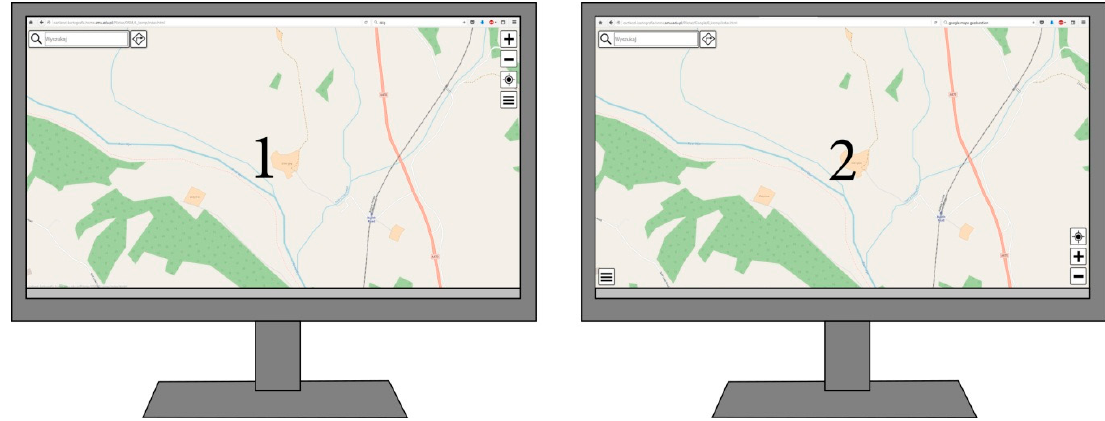
Figure 4. Web map and the unified GUI design according to ( 1 ) OpenStreetMap and ( 2 ) Google Maps.